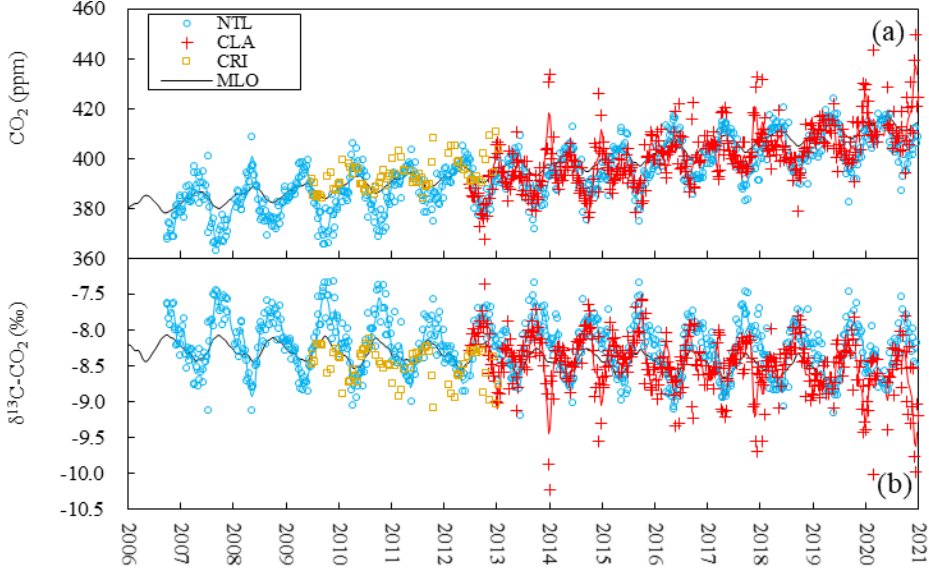
Figure 4. Time series of the (a) atmospheric CO 2 mole fraction and the (b) isotope ratio of δ 13 C-CO 2 at NTL, CLA, CRI, and MLO in 2006–2020.